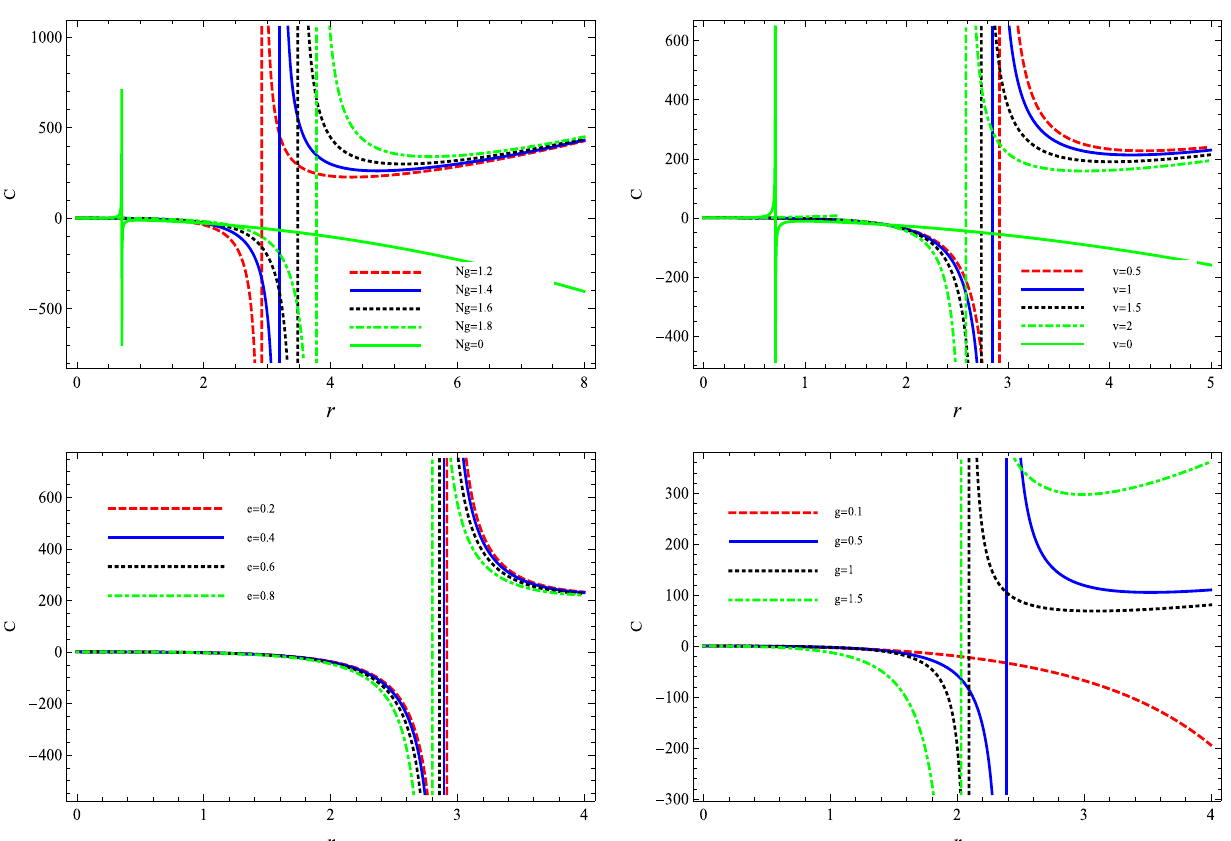
Fig. 6 The variation of heat capacity with ‘r’ for different values of NUT charge N g (Top left), magnetic charge ν (Top right), electric charge e (Bottom left) and gauge coupling constant (g)